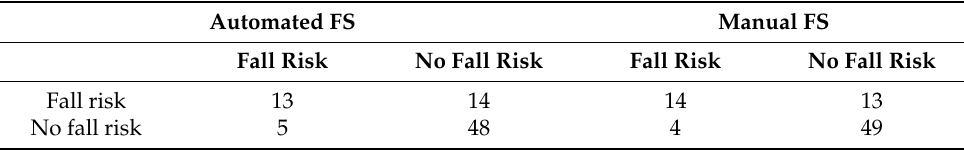
Table 5. Fall risk classification confusion matrices for automated and manual foot strike (FS) identification. Automated FS Manual